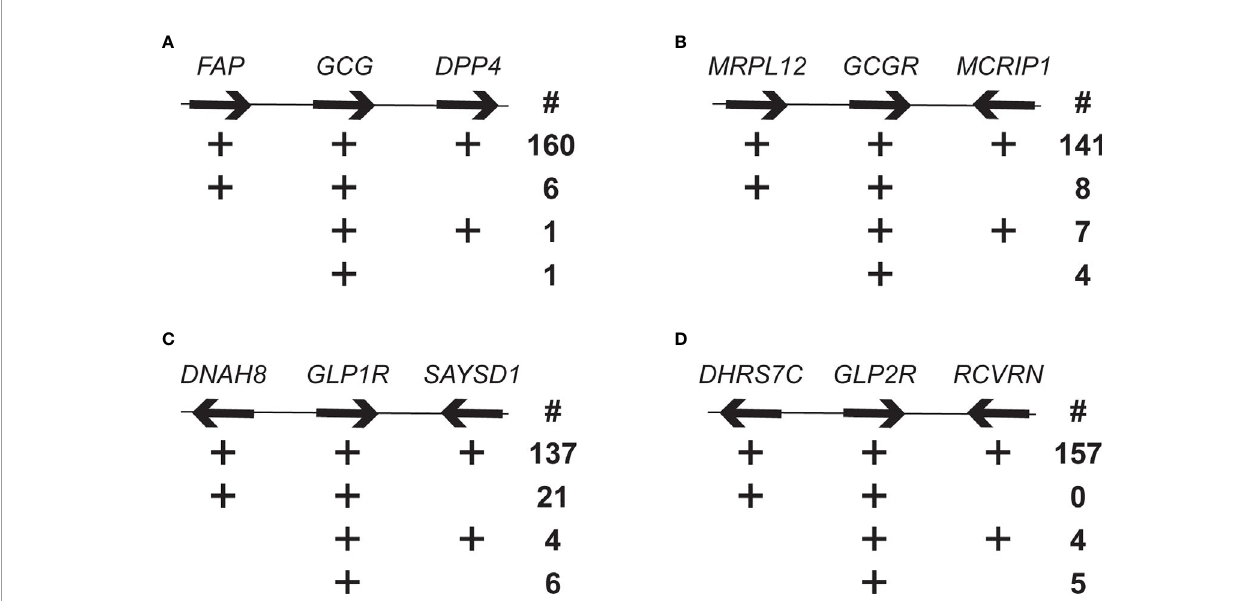
FIGURE 1 | Genomic neighborhood analysis of mammalian Gcg , Gcgr , Glp1r , and Glp2r genes. Number of mammalian genomes having genomic neighborhoods for the (A) Gcg , (B) Gcgr , (C) Glp1r , and (D) Glp2r that are similar tom the human genomic neighborhoods. Organization of selected genes fl anking the human GCG , GCGR , GLP1R and GLP2R genes, with arrows indicating direction of transcription. Genes and intergenic spaces are not shown to scale. The four rows below each gene are different genomic neighborhood found in the annotated mammalian genomes. The plus symbol (+) indicates presence of the gene and the number (below the # symbol) to the right is the number of species with that type of genomic neighborhood. Genes are: FAP , fi broblast activation protein; DPP4, dipeptidyl peptidase 4; MRLP12 , mitochondrial ribosomal protein L12; MCRIP1 , MAPK regulated corepressor interacting protein 1; DNAH8 , dynein axonemal heavy chain